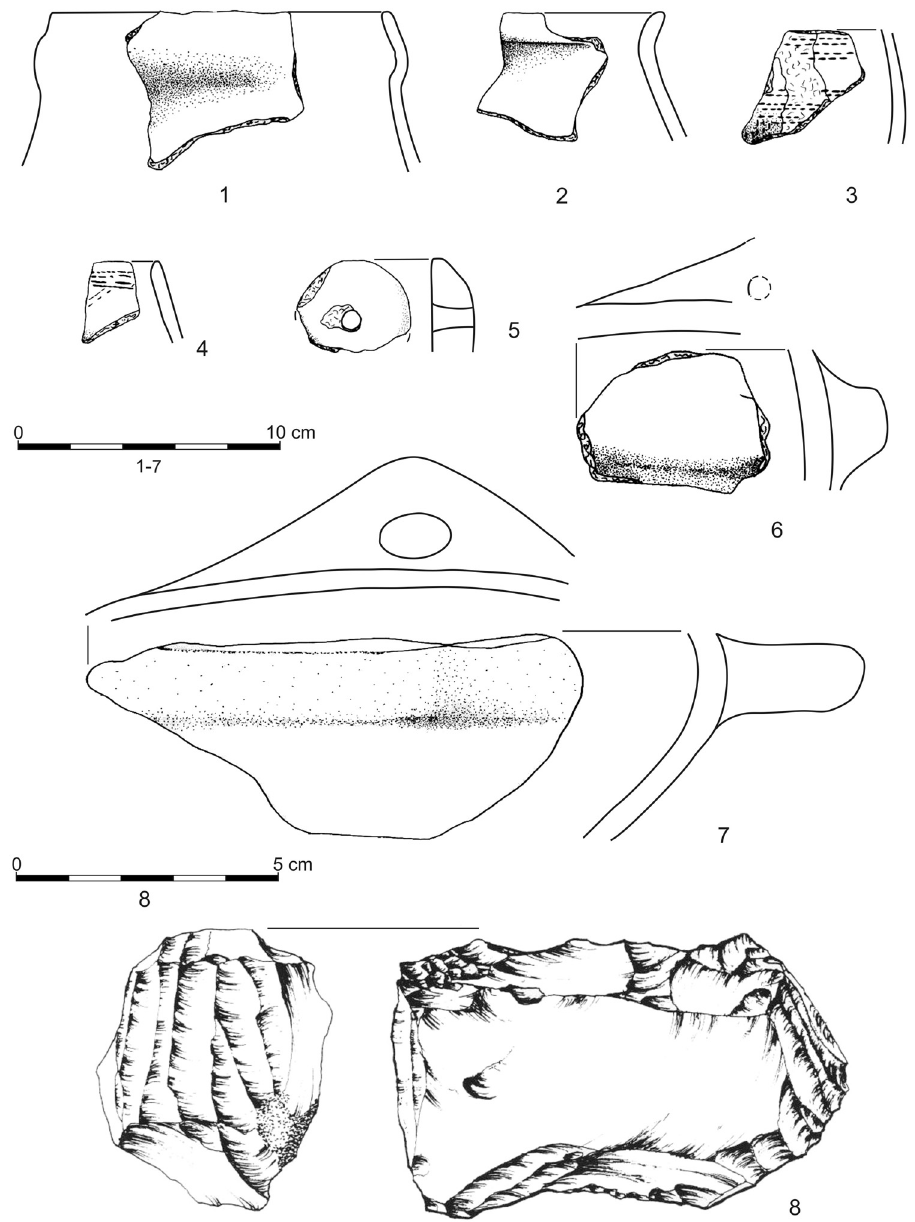
Figure 4: Jurków, com. Czchów, site 1. Samborzec - Opatów pottery ( 1 – 7 ) and fl int core ( 8 )